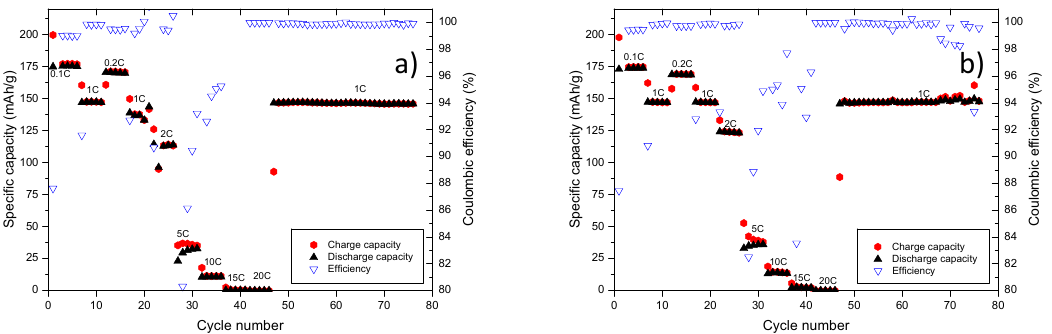
Figure 10. Cycling profiles including charge/discharge rate test of NCM/graphite cells containing ( a ) 1 M LiPF 6 in EMS:EA (1:1) with 4% FEC and ( b ) 1 M LiPF 6 in EC:DEC (3:7) electrolytes in the voltage range between 3.0 and 4.3 V vs. Li/Li + .